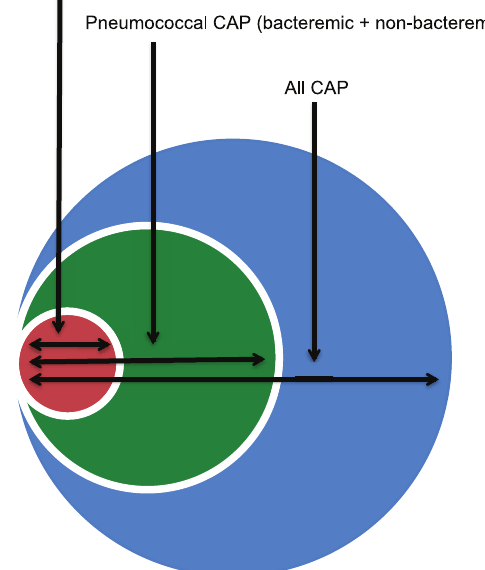
Figure 1. The relationships between CAP 1 , non-bacteremic pneumococcal pneumonia, and bacteremic pneumococcal pneumonia.